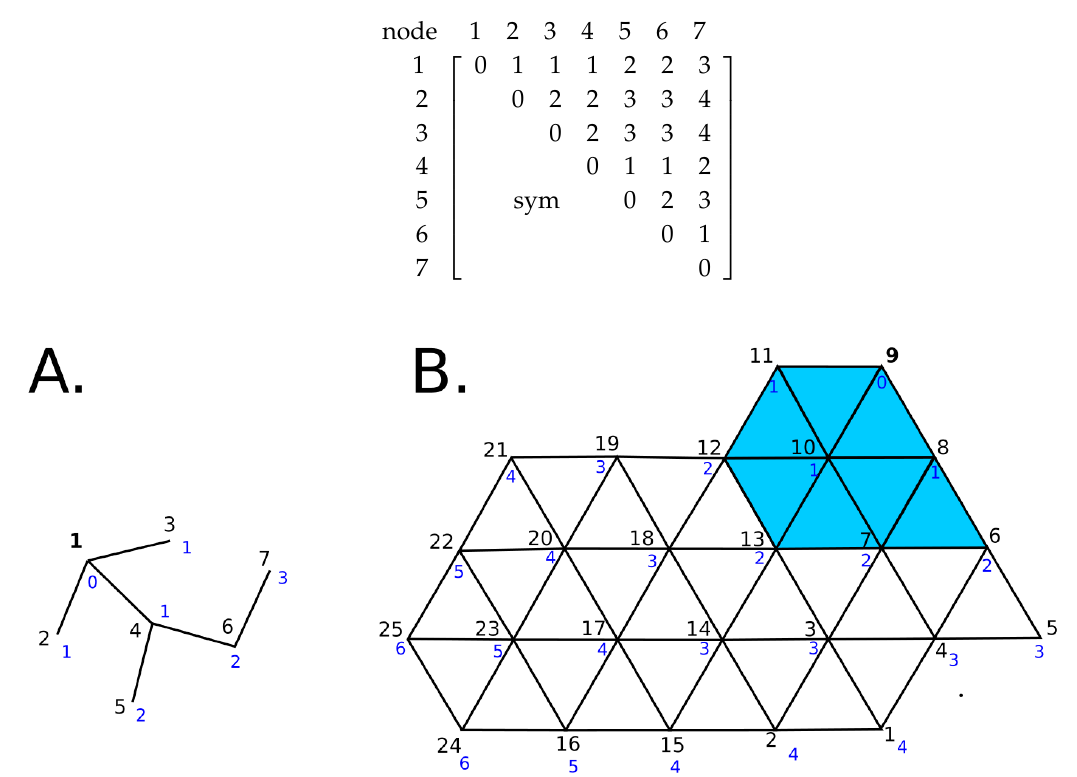
Figure 5. Distances between connected nodes in the graph-method. Node numbers are represented in black. ( A ) Distances from node 1 are shown in blue; ( B ) Distance from node 9 are shown in blue and triangles with nodes at a distance of less than two edges from node 9 are colored in